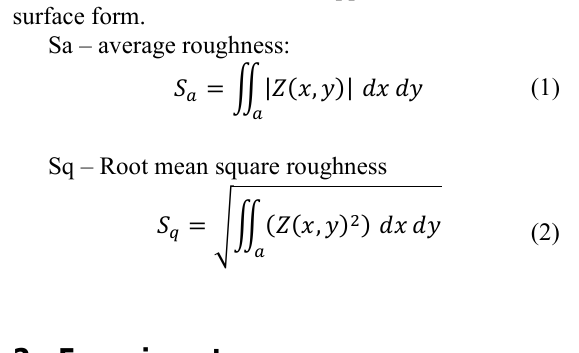
Table 2 . Parameters of the grinding proceses for each tool .